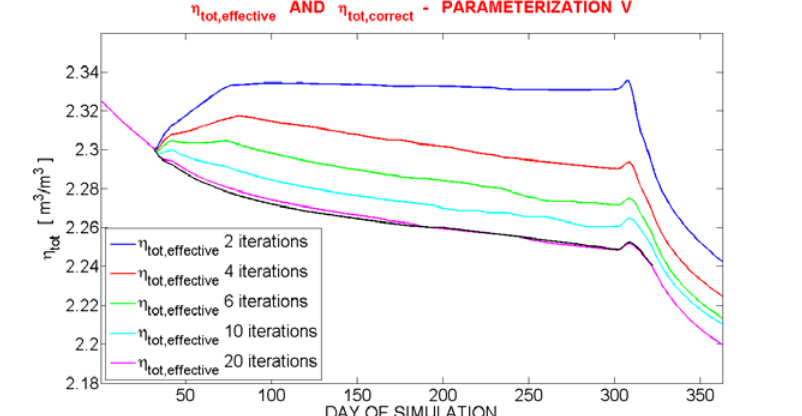
for parameterization V without correction (black line) and Figure 13. Trends of η tot;correct with corrections (other lines) and with different iterations of η tot;effective